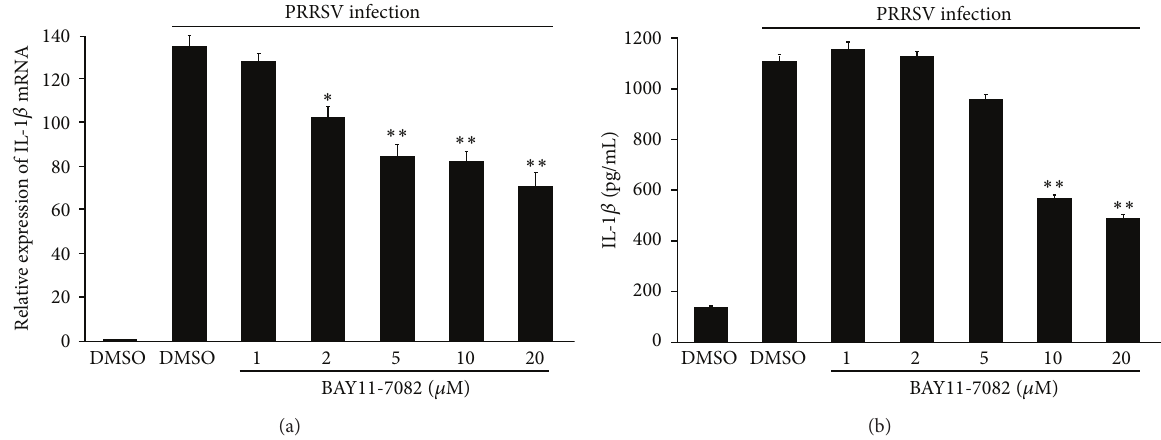
Figure 5: NF- 𝜅 B is required for PRRSV-induced IL-1 𝛽 production. (a, b) PAMs were mock infected or infected with PRSSV at a MOI of 0.1, followed by treatment with NF- 𝜅 B inhibitor (1, 2, 5, 10, and 20 𝜇 M) or DMSO vehicle in the absence of serum, for 36h. The cells and supernatants were then harvested separately and analyzed by real-time RT-PCR (a) and ELISA (b), respectively. ∗ 𝑃 < 0.05 and ∗∗ 𝑃 < 0.01 compared with DMSO-treated cells plus PRRSV